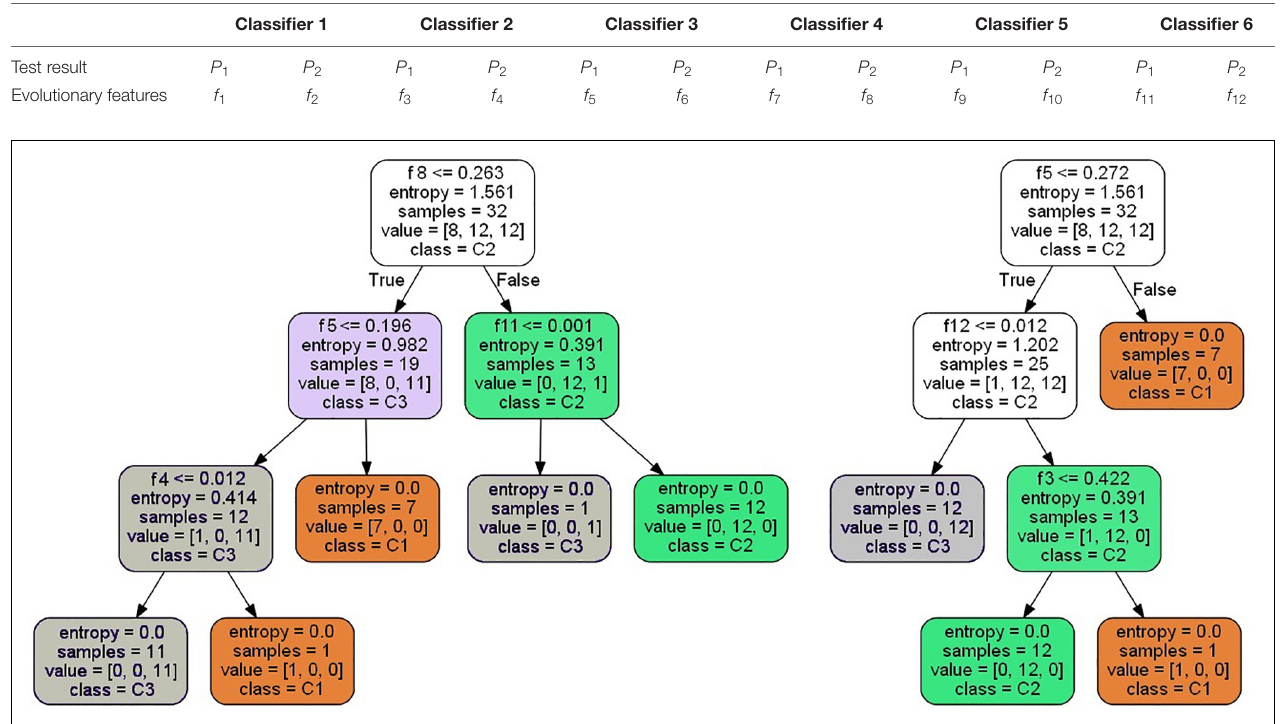
TABLE 3 | Corresponding relations among the evolutionary features and the test results of the long short-term memory classifiers.